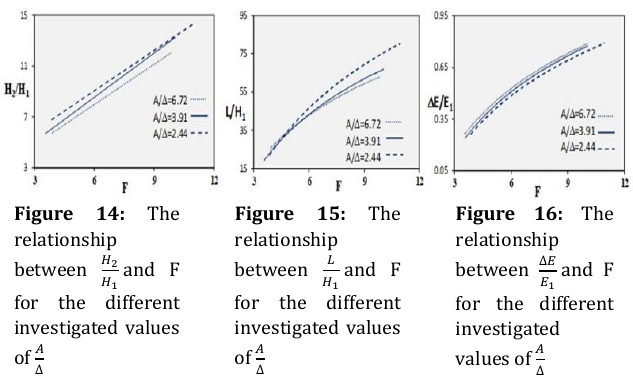
Figure 15: The relationship between 𝐿 and F 𝐻 1 for the different investigated values of 𝐴 ∆